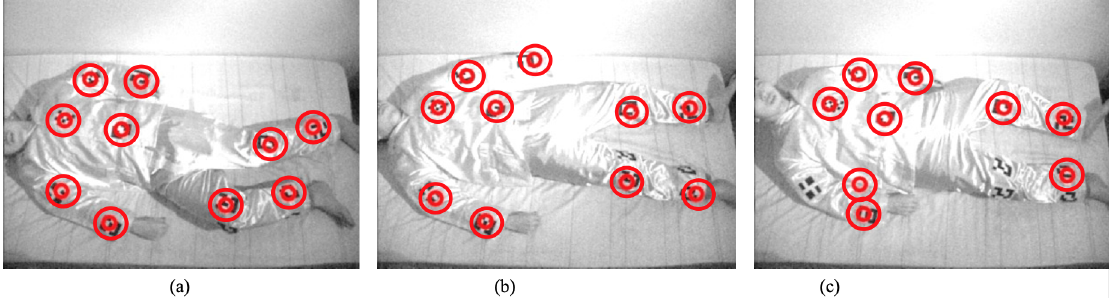
Figure 7. Examples of joint detection results. Each double-red circle represents a detected joint. ( a ) Lateral pose with ten successful detections. ( b ) Supine pose with ten successful detections. ( c ) Supine pose with eight successful detections. The right-knee and right-elbow joints are missed because of great distortion induced by perspective and cloth’s